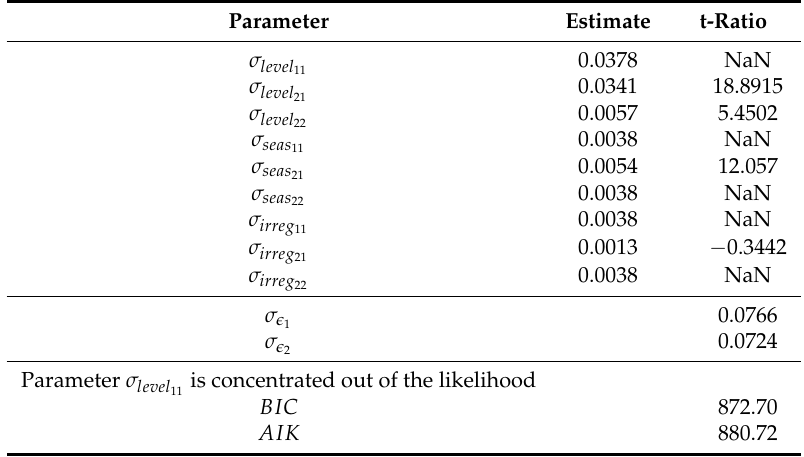
Table A18. Endogenous variables: log IPI manufacture of gas; distribution of gaseous fuels through mains log natural gas